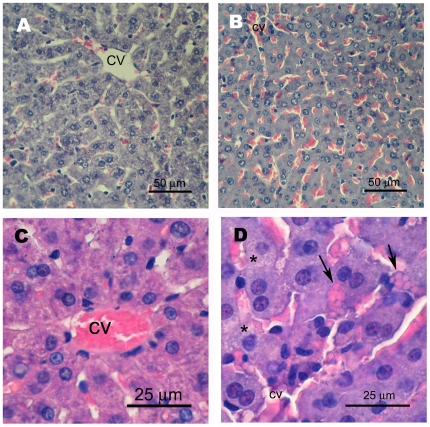
Representative photomicrographs of livers from rats treated 48 h earlier with vehicle (5% DMSO in corn oil, A and C) or 199 mg/kg 2,6DNT (B and D).Photomicrographs are from 5 µm sections stained with hematoxylin and eosin. Extensive sinusoidal congestion of 2,6DNT-treated rats is shown in panel B and compared to unaffected liver of vehicle treated controls in panel A. Higher power magnification illustrates infiltration of hepatocyte cords by erythrocytes (D, arrows) and microvesiculation (D, *) seen in livers of 2,6DNT-treated rats. Unaffected liver of vehicle-treated controls at high magnification is shown in panel C.